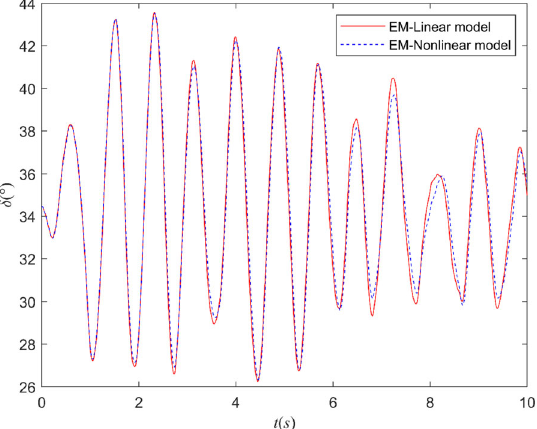
Fig. 3 Comparison of power angle curves between linear and nonlinear models of the system ( σ = 0.198)